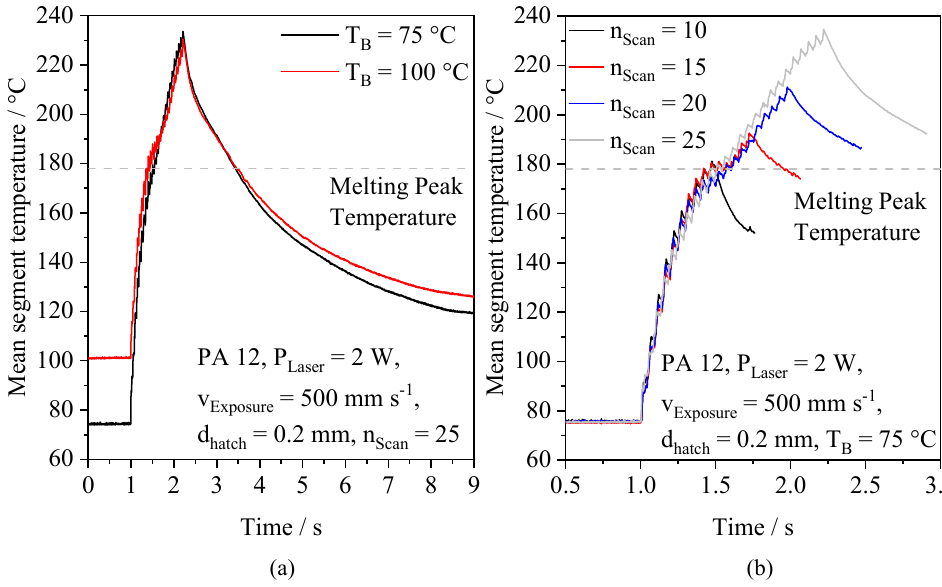
Figure 7. Influence of varying powder bed temperatures ( a ) and varying scan numbers ( b ) on resulting mean temperatures, occurring for the exposure of single, consecutively exposed segments.